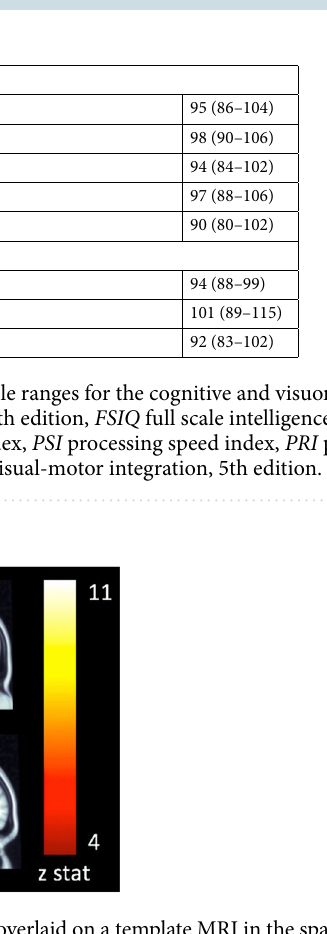
Figure 1. Resting state networks overlaid on a template MRI in the space of the Montreal Neurological Institute.